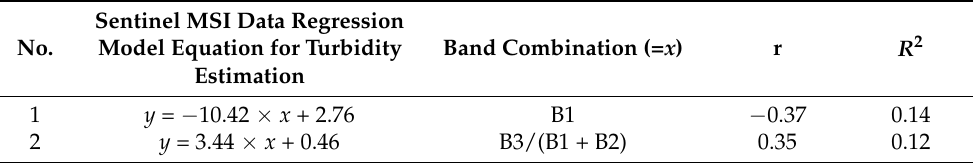
Table 11. Regression model for the retrieval of turbidity concentration using Sentinel MSI training datasets.